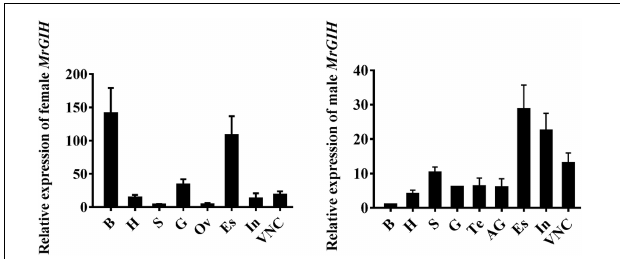
FIGURE 4 | Tissue distribution analysis of Mr GIH. Different tissues from healthy female and male M. rosenbergii were as followed: Brain (B), Heart (Ht), Stomach (S), Gills (G), Testis (Te), Ovary (Ov), Androgenic gland (AG), Eyestalk (Es), Intestine (In), and Ventral Nerve Cord (VNC). β -actin gene is as an internal reference to normalize Mr GIH mRNA.